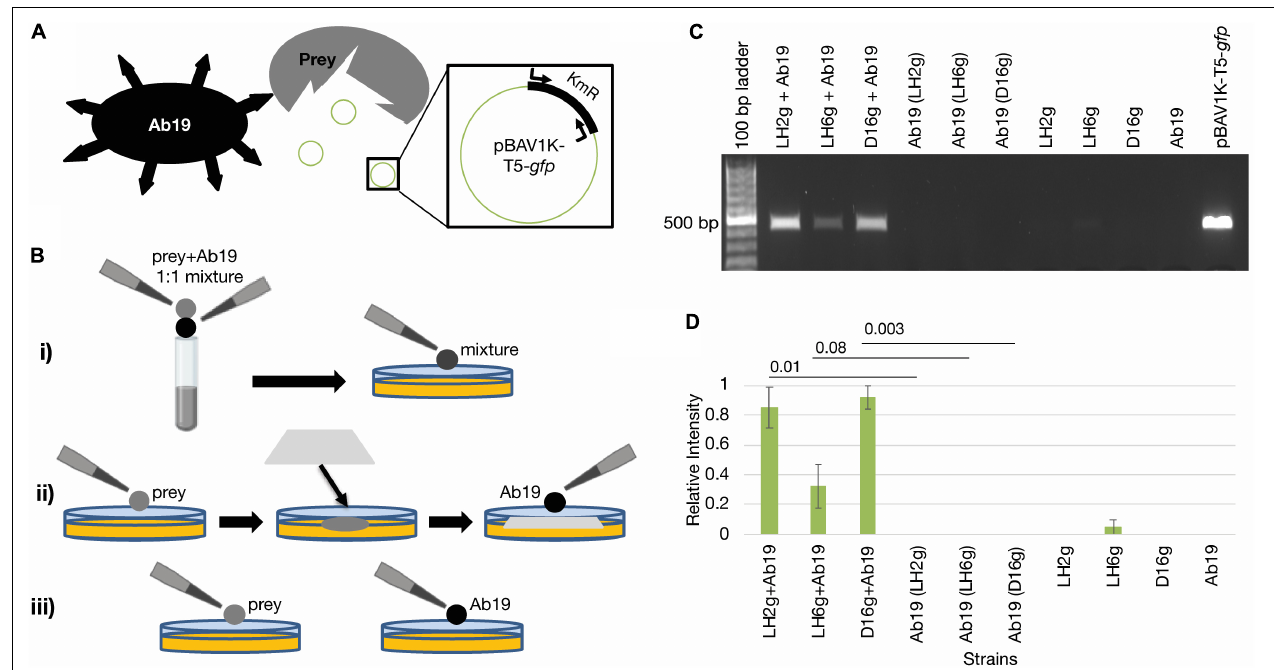
FIGURE 2 | Contact-dependent DNA release. (A) Schematic showing assay concept. The predator strain (Ab19) liberates the pBAV1K-T5- gfp plasmid from the prey strains being tested. Then the presence of the plasmid is detected by amplification of the KmR gene on the plasmid. (B) Schematic detailing the different incubation conditions being used. (i) Prey strain and Ab19 are mixed 1:1 and spotted directly onto the agar plate; (ii) prey strain and Ab19 are separated by a membrane; (iii) controls include incubations of each strain on the plates individually. (C) A 1.0% agarose gel depicting the PCR-based KmR gene (450 bp) detection of released DNA mediated by contact dependent killing representative of triplicate experiments shown in Supplementary Figure S1 . Co-cultures separated by a membrane to inhibit T6SS are denoted with parentheses. (D) Relative intensities of PCR products in each lane from Supplementary Figure S1 were measured by densitometry using Image LabTM. The band produced by amplification of pBAV1K-T5- gfp was used as the standard (Rel. Intensity = 1.0). The averages are represented, and error bars represent the standard error of the mean. Student’s paired T -tests were performed for each co-incubation compared to its corresponding membrane-separated control incubation. The p -values for the LH2g, LH6g, and D16g datasets are